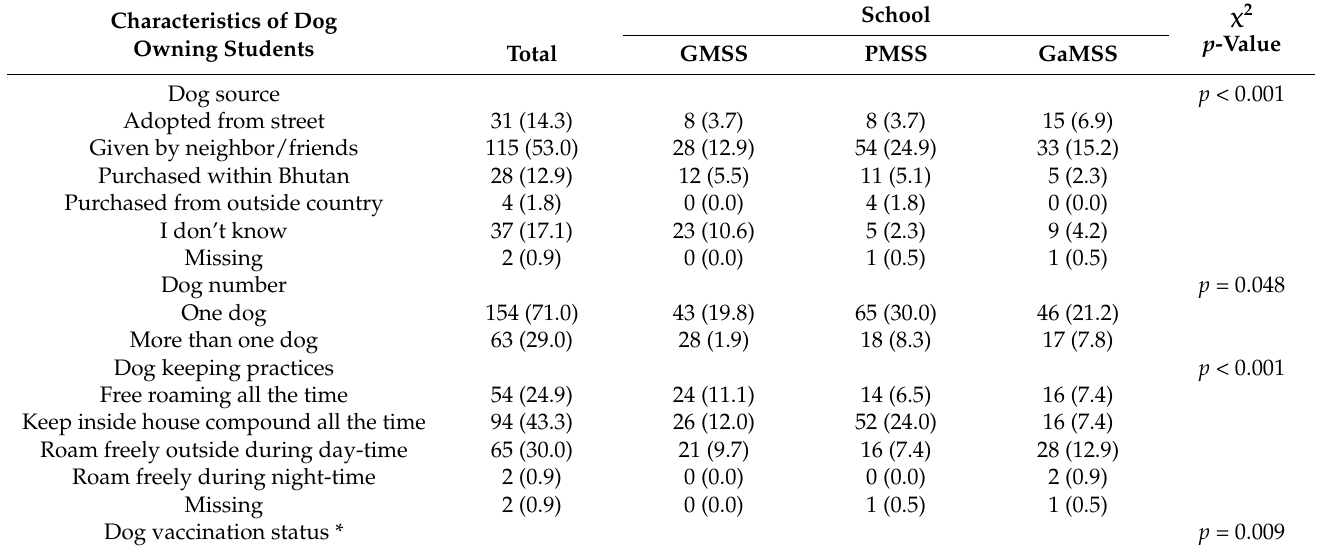
Table 2. Characteristics and management of dogs owned by students’ households in three rabies endemic towns of Bhutan ( n = 217; Phuntsholing, Gelephu,